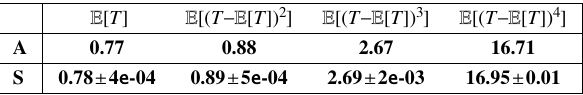
Table 2: Class 2 response time moments from TCP dataset